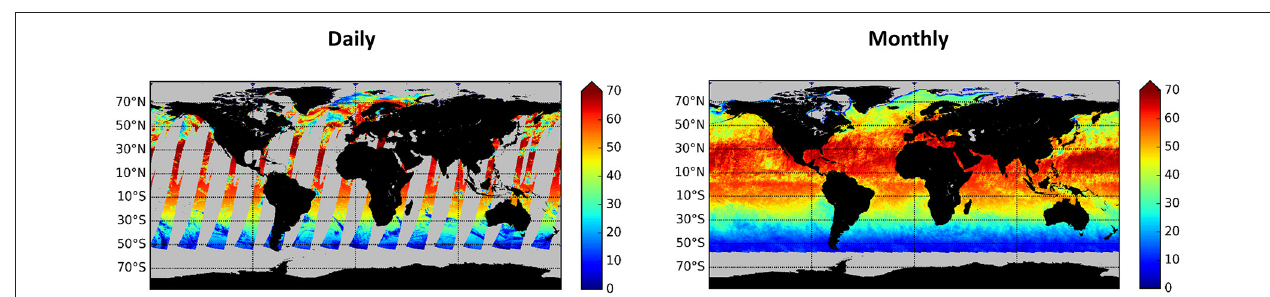
FIGURE 15 | Daily, and monthly scalar PAR below surface (unit: E/m 2 /day), 0.1 ◦ spatial resolution derived from MERIS. Top Left : May 15, 2011; Top Right : May 1–31, 2011.